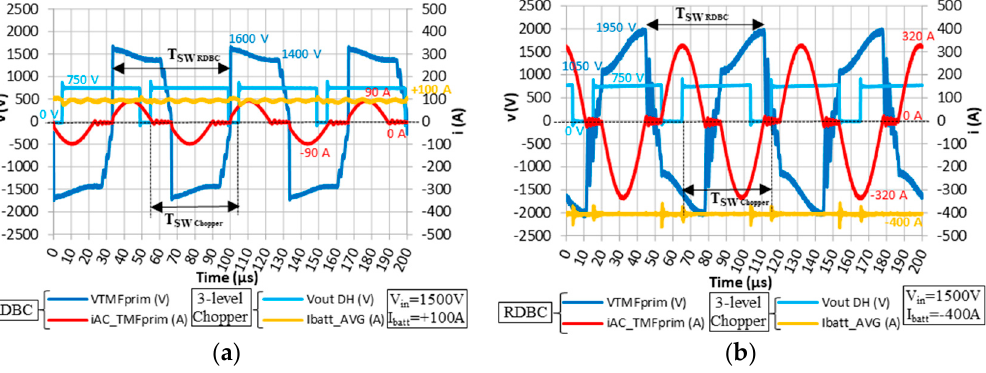
Figure 18. Elementary block of 300 kW/147 kWh. Instantaneous waveforms: ( a ) ba tt ery charging at maximum current (i ba tt = 100 A); ( b ) ba tt ery discharging at maximum current (i ba tt = 400 A).